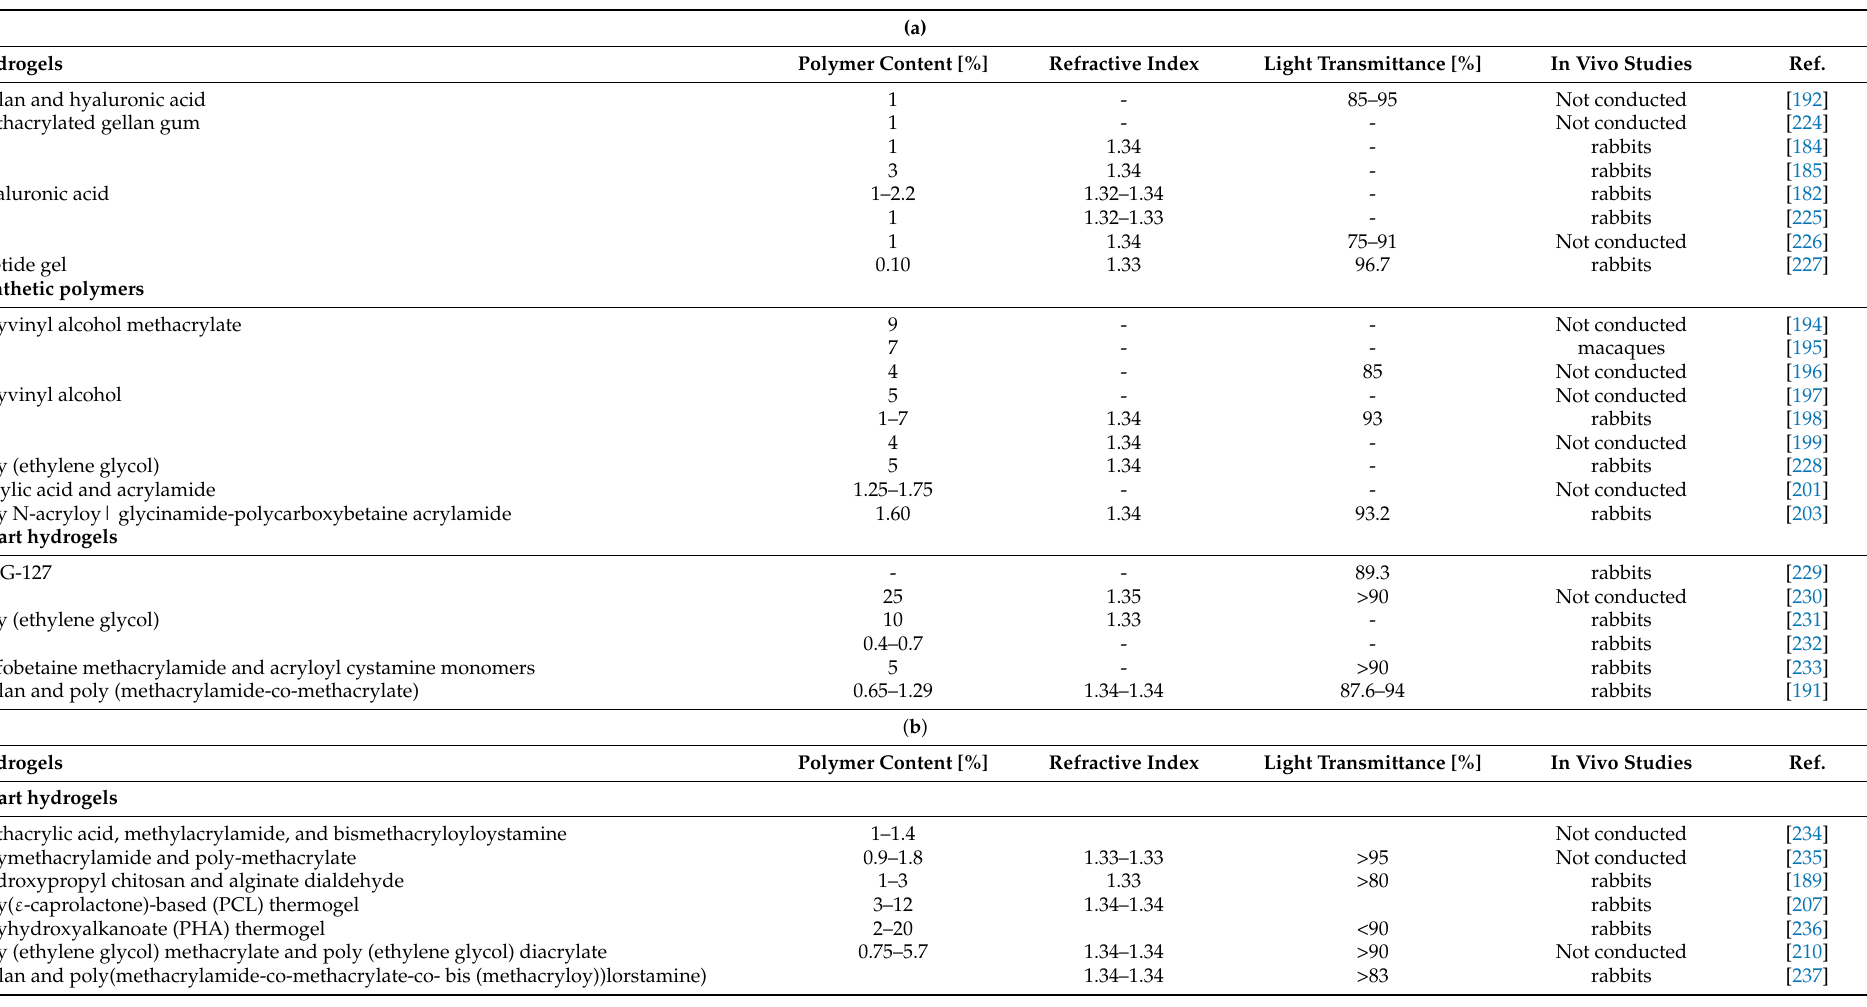
Table 2. ( a ) Overview of hydrogels-based vitreous substitutes. ( b ) Overview of hydrogels-based tamponades-based vitreous substitutes.